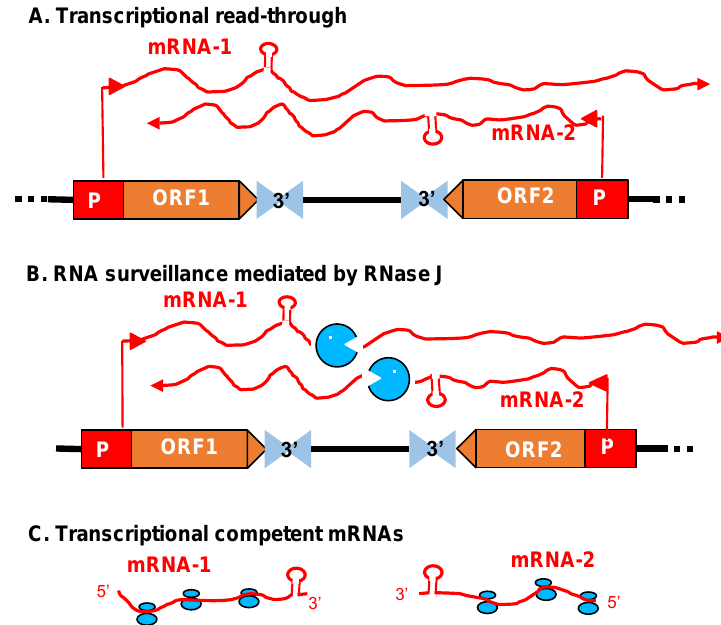
Figure 4. Model for antisense RNA (asRNA) surveillance by chloroplast RNase J. ( A ) 3′ UTRs of chloroplast genes inefficiently terminate transcription, resulting in read-through (mRNA-1 and mRNA-2). Where genes are convergently transcribed, even at a distance, asRNA may be synthesized.